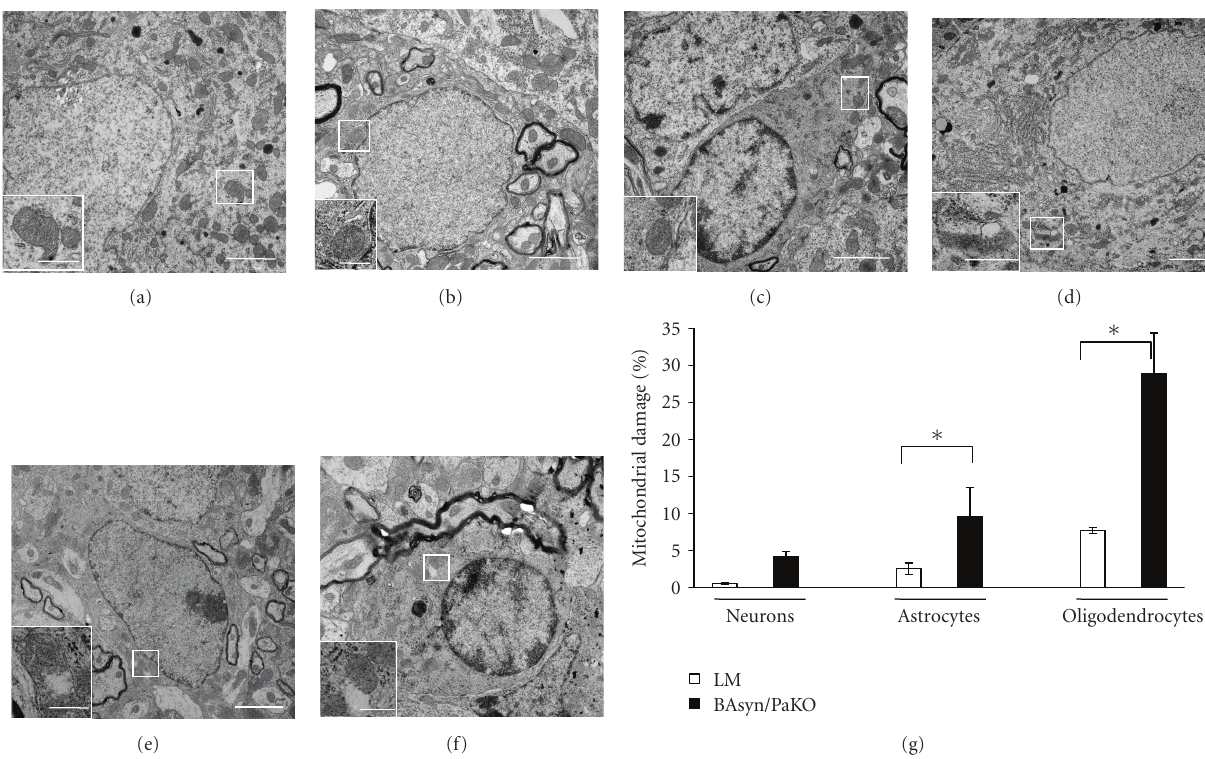
Figure 3: Mitochondrial ultrastructure in the spinal cord of 8m-old BAsyn/PaKO. Exemplary ultrastructural features of neurons, astrocytes, and oligodendrocytes are shown for LM ((a)–(c)) and BAsyn/PaKO ((d)–(f)). Higher magnifications show examples of healthy or damaged mitochondria. Scale bars: (a)–(f): 2 μ m; higher magnification of (a)–(f): 0.5 μ m. The quantification of mitochondrial alterations is shown in (g), n = 3, errors bars = SD, U -test, ∗ P < . 05.